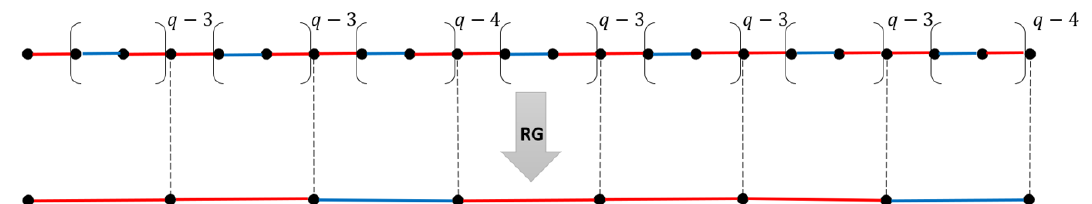
Figure 8: Top line: Rescaled sequence appearing in the bottom line of Fig. 7 after the first RG step. Applying a second RG step (38), ( q − 3 ) blocks and their preceding bonds get renormalized to a weak coupling J (cid:48)(cid:48) , while the ( q − 4 ) blocks are renor- a malized to a strong coupling J (cid:48)(cid:48) , both given in (39). Bottom line: After two RG b steps, we recover the original sequence, indicating that the bond attractor for { 6, q } modulations is a